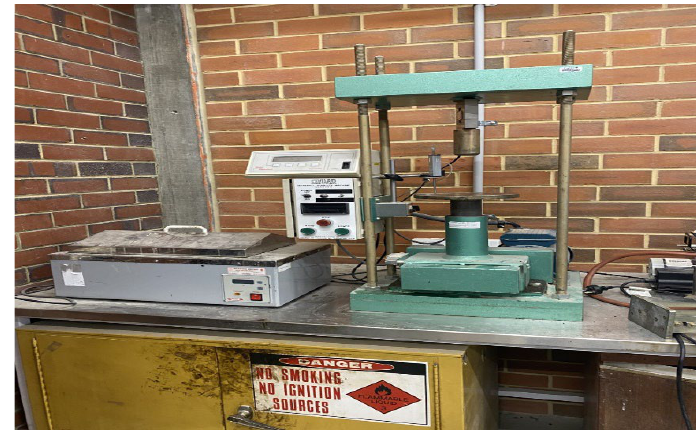
Figure 2. Marshall tests at Curtin University.